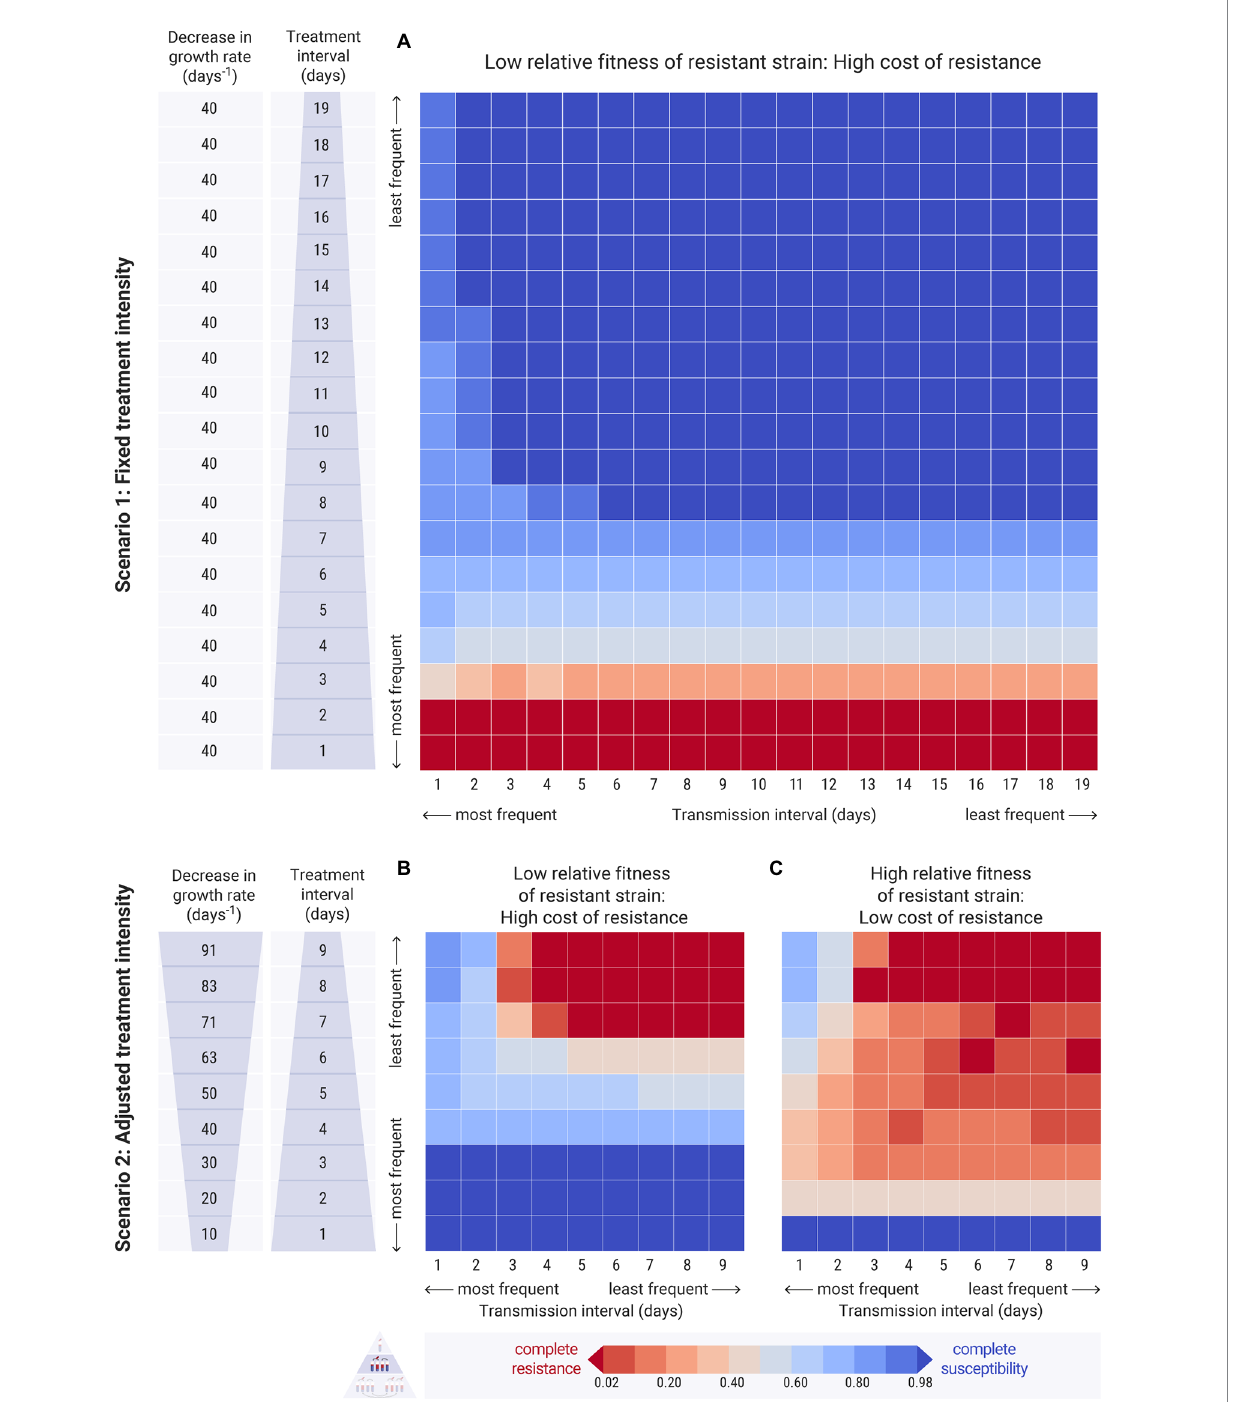
more similar (Figure 7B: bottom panel). Surprisingly though, frequent transmission also attenuated resistance levels (Figure 7: top panels). Specifically, when a population receiving frequent